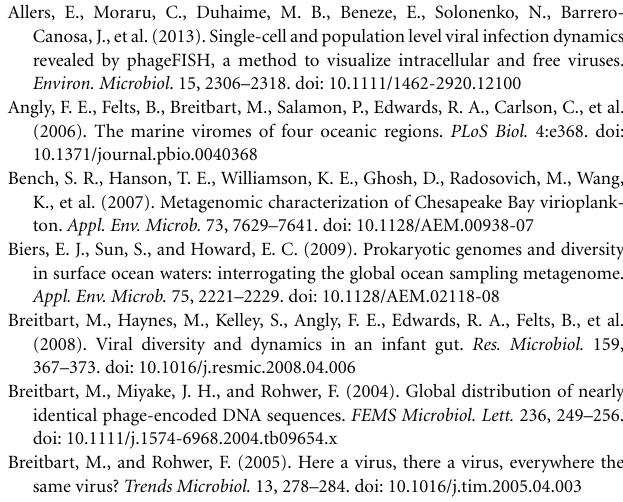
Figure S1 | Fragment recruitment of viral ssDNA reads onto assembled environmental gokushovirus genomes. Each assembled genome (Lake_Bourget_052, Lake_Bourget_523, Lake_Pavin_279, 68_Microbialite_063, and SARssphi2) is represented by a different panel. Each horizontal line represents a read recruited from one of the metagenomic data sets from this study: Gulf of Mexico (dark red), Saanich Inlet (Dark blue), and Strait of Georgia (aqua). Reads were recruited against each of the assembled genomes using tBLASTx with an e -value of 10 − 10 . The position of each line represents the percent similarity of the read to the genome. VP1 is represented by a red arrow. Figure S2 | Fragment recruitment of reads from environmental viral metagenomes to show the regions of conservation within different environments. Each assembled genome (Lake_Bourget_052, Lake_Bourget_523, Lake_Pavin_279, 68_Microbialite_063, and SARssphi2) is represented by a different panel. Each horizontal line represents a read recruited from one of the following publicly available metagenomic data sets: Gulf of Mexico (dark red), Strait of Georgia (aqua), Sargasso Sea (orange), Lake Bourget (light green), Lake Pavin (dark green), and microbialites (purple) metagenomic data sets on each of the assembled genomes that recruited at using tBLASTx with an e -value of 10 − 10 . The height of line represent the percent similarity of the read to the genome. VP1 is represented by a red